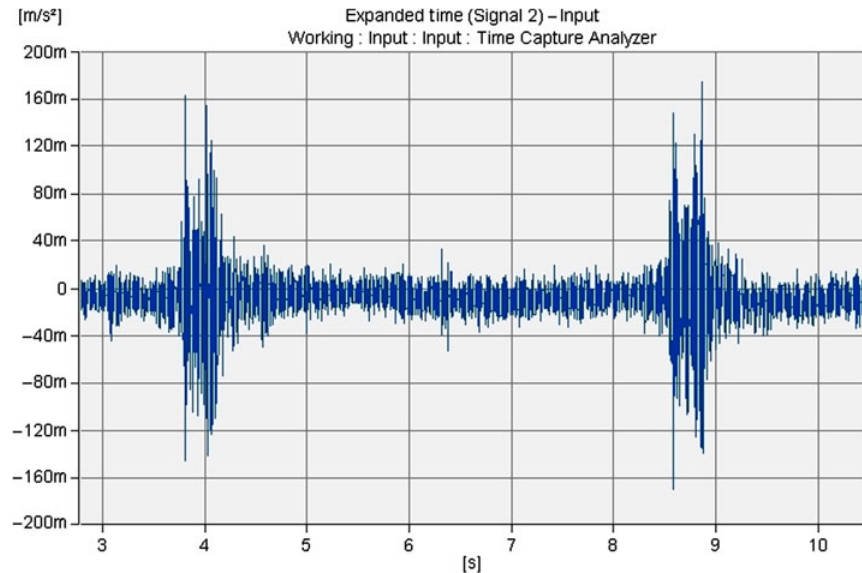
Fig. 11. Acceleration measured on the press 2 (Signal